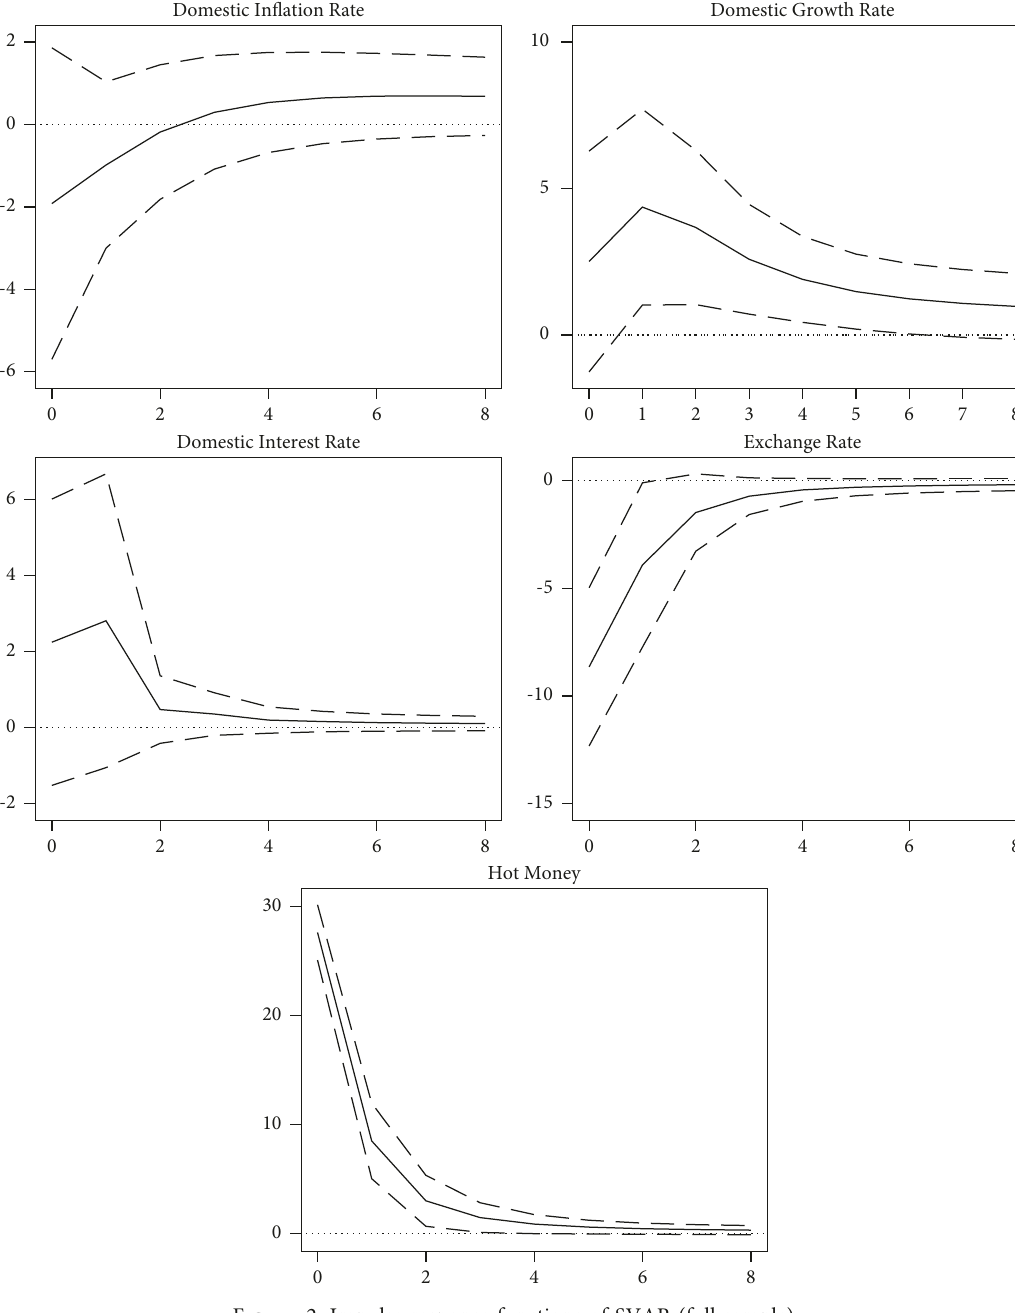
Figure 2: Impulse response functions of SVAR (full